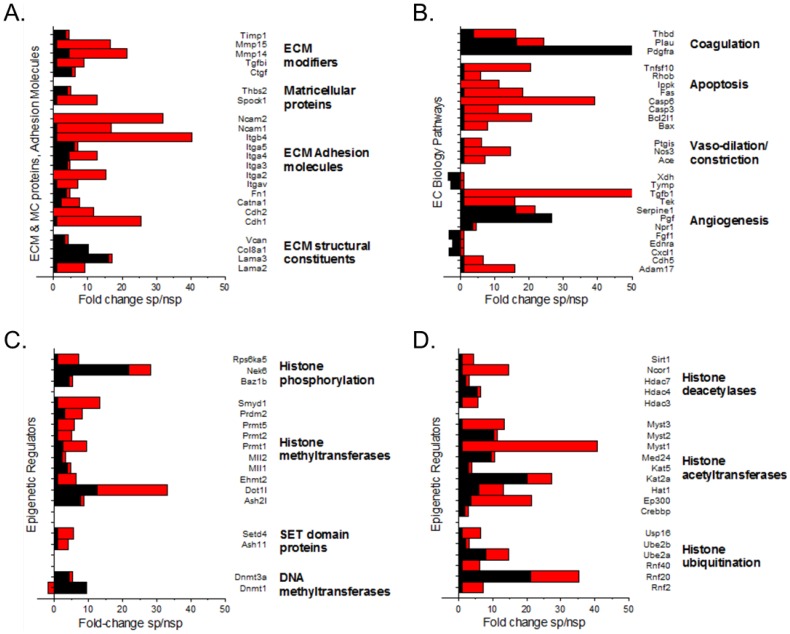
RT-PCR array profiling in aortas and left common carotid artery (LCCA) of stoke-prone (SP) and non stroke-prone (nSP) Dahl S female rats at six weeks of age.Pathway-specific RT2-qPCR array comparative analysis of gene expression changes in LCCA (red bars) and aorta (black bars) at 6-weeks of age representing ratio of SP/nSP RNA levels. A) Extracellular matrix (ECM) and matricellular (MC) protein pathway-specific significant gene changes. B) Endothelial Cell (EC) Biology pathway-specific gene changes. C and D) Epigenetic regulator pathway-specific gene changes. SP (0.4% NaCl); nSP (0.23% NaCl) from gestation. Gene expression changes shown are limited to ≥ 2-fold change and p<0.01 in either vessel. Only statistically significant differences are presented (P<0.05, Two Way ANOVA followed by Holm-Sidak Test for multiple comparisons; Tables S1–S6).